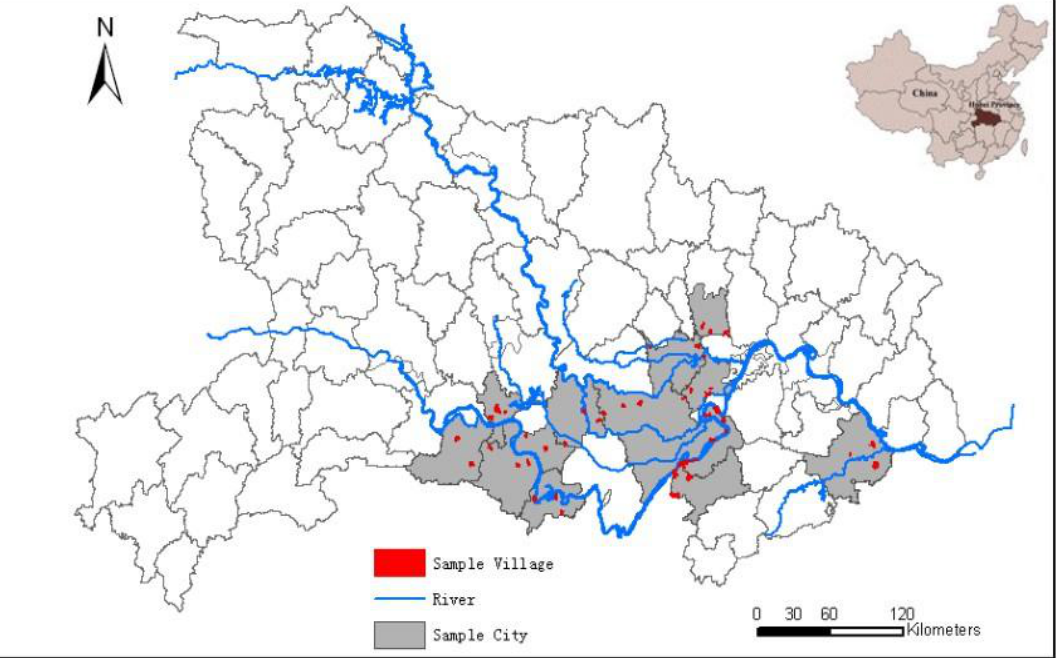
Figure 1. Sampled distribution of the study cities and villages in the lake region, Hubei Province,